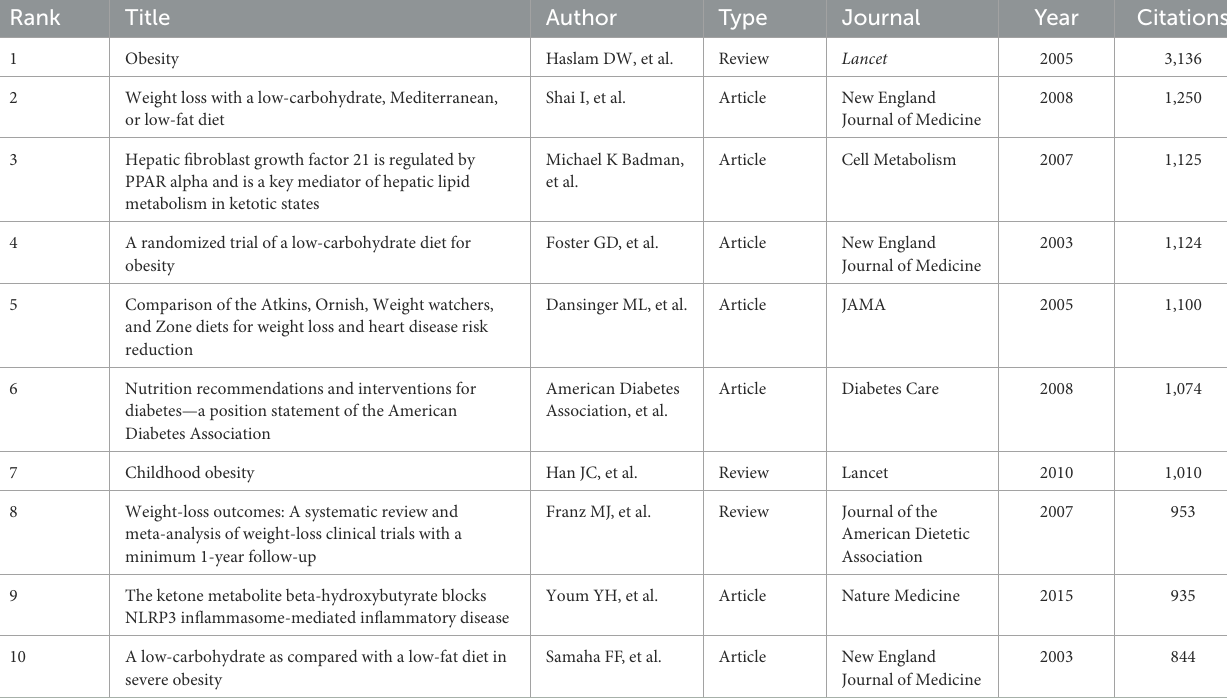
TABLE 7 The top 10 cited references on LChD from 2002 to 2021.